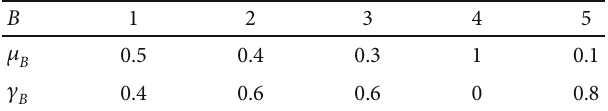
Table 10: Intuitionistic fuzzy set B .